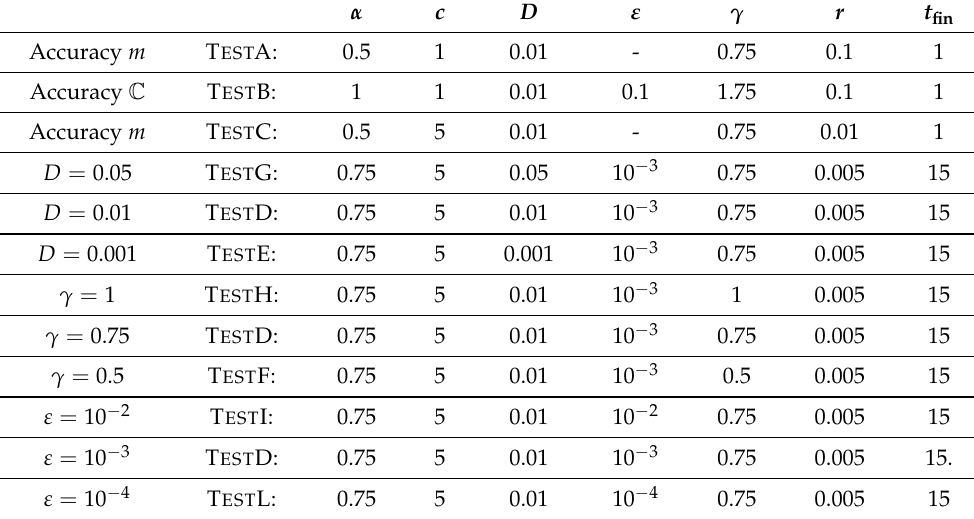
Table 1. In this table, we define all the tests that we show in Section 4.1. The first three rows show the parameters for the accuracy tests for m and C , and the results are summarized in Tables 2 and 3. The second three rows define the parameters that we use in Figure 2, where we compare the results of changing the diffusivity. The third three rows are the tests showed in Figure 3, varying gamma , and the results of the last three rows are in Figure 4, where we change the stabilization parameter ε . For the accuracy tests, the number of points of the discretization is specified in Tables 2 and 3, while for all the other tests, the number of points is fixed, and it is N = 600.